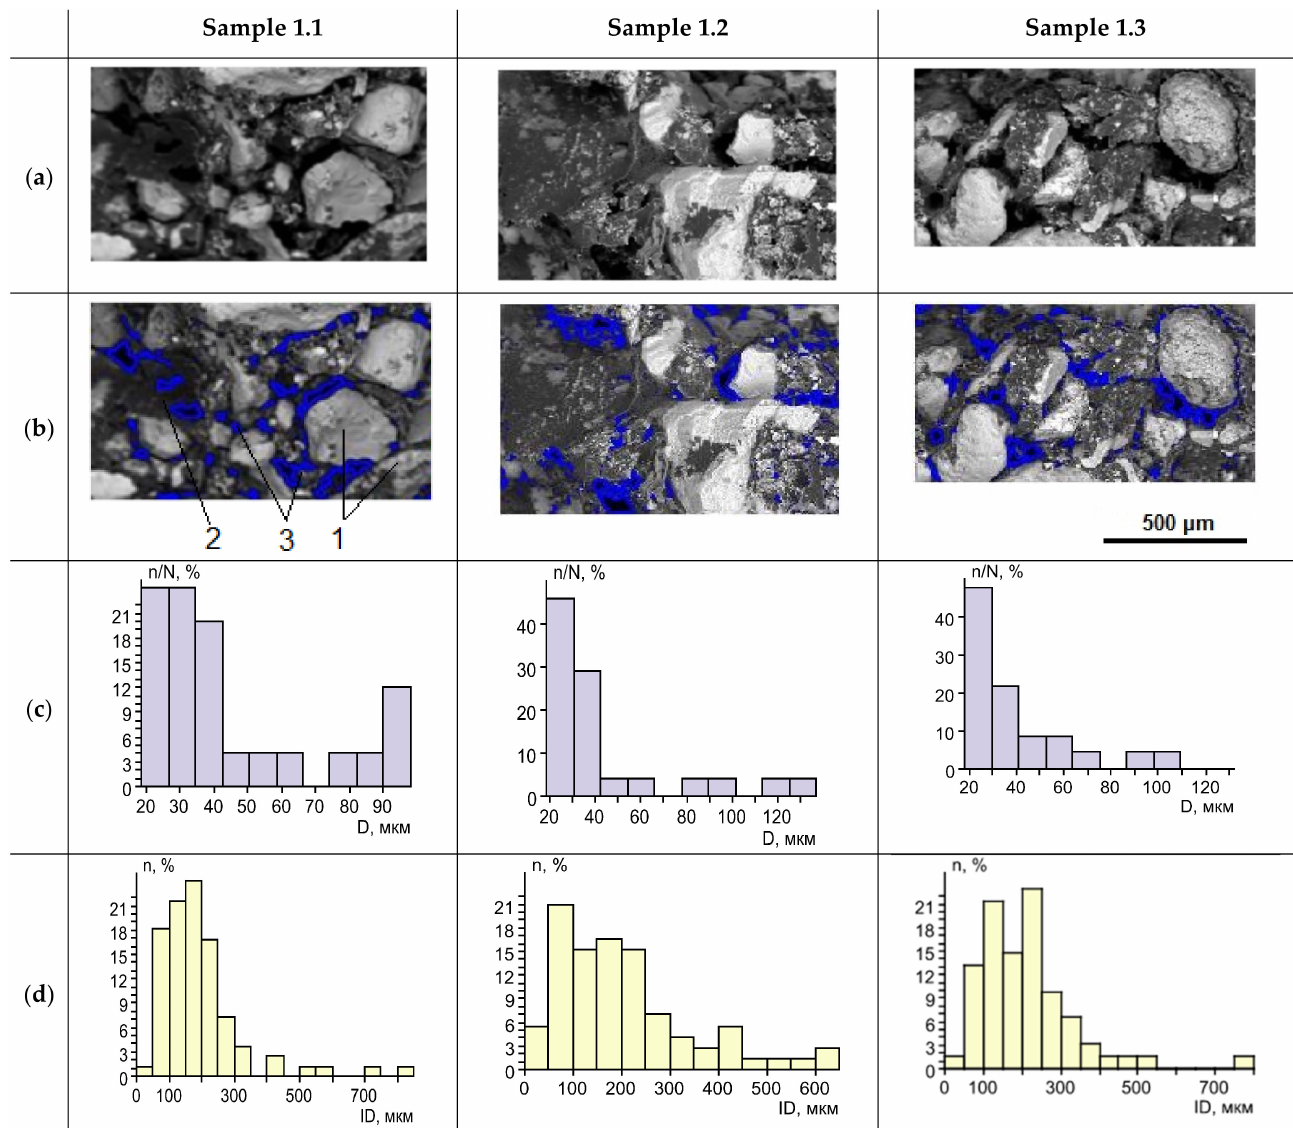
Figure 6. The structure of sand, reinforced by the stepwise injection of the two-component silicate resin. ( a ) Backscattered electron images of the samples; ( b ) the images with highlighted inter-grain voids: 1—sand grains; 2—aggregates of cured polymer resin; 3—inter-grain voids; ( c ) histogram of the void sizes (D—diameter) distribution; ( d ) distribution of the inter-void